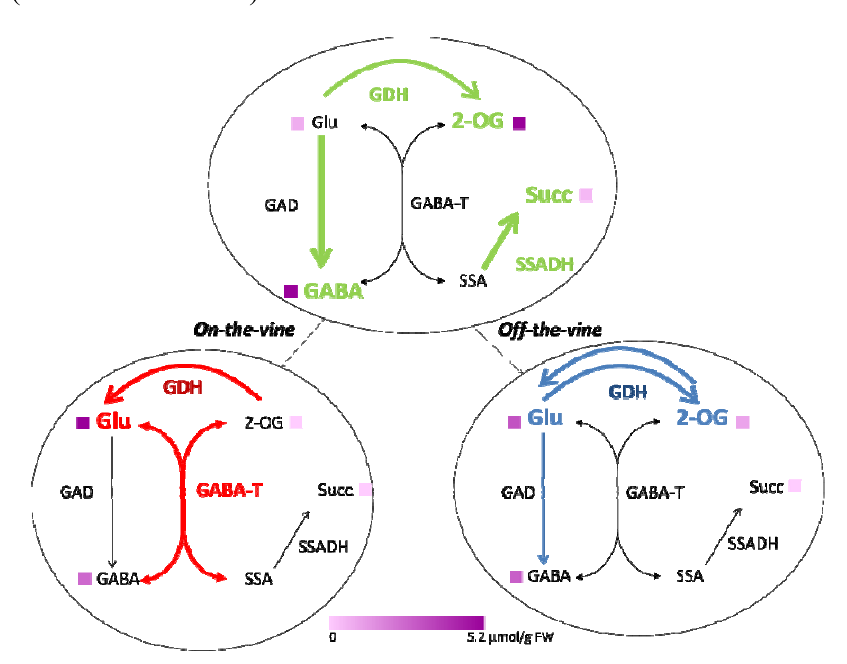
Figure 3. Metabolism of glutamate and GABA in tomato fruit. Enzymes and metabolites measured in mature green fruit (upper part), and fruits ripened on- and off-the-vine (lower part) are shown. Colored arrows and letters indicate increased levels in mature green fruit (green), on-the-vine (red) or off-the-vine (blue). Thickness of arrows and size of letters are proportional to corresponding reaction activity (taken from Table 2) and metabolite accumulation, respectively. At the bottom, a violet scale representing the content of each metabolite (taken from Table 1) is